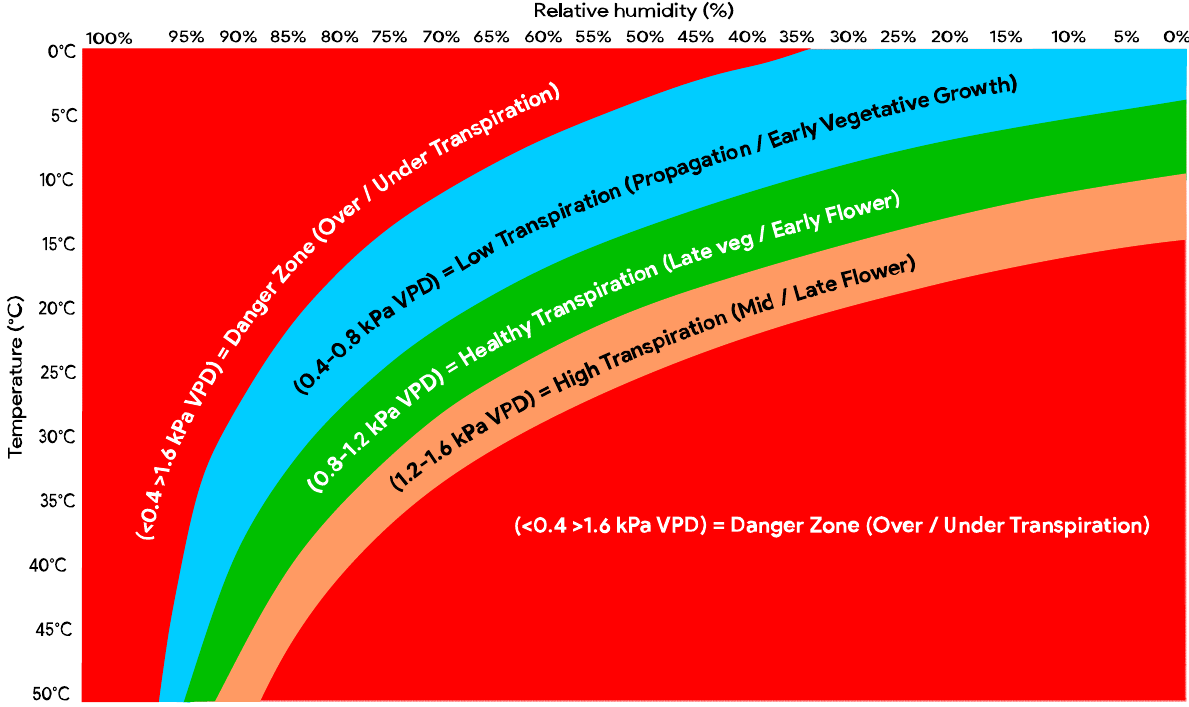
Figure 10. Vapor pressure deficit (VPD) profile and growth stages of plants inside a greenhouse.